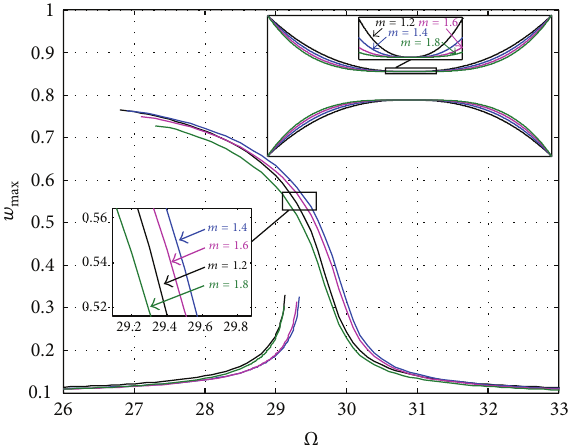
Figure 10: Comparison of dynamic response curves of different midsection width 𝑓 .